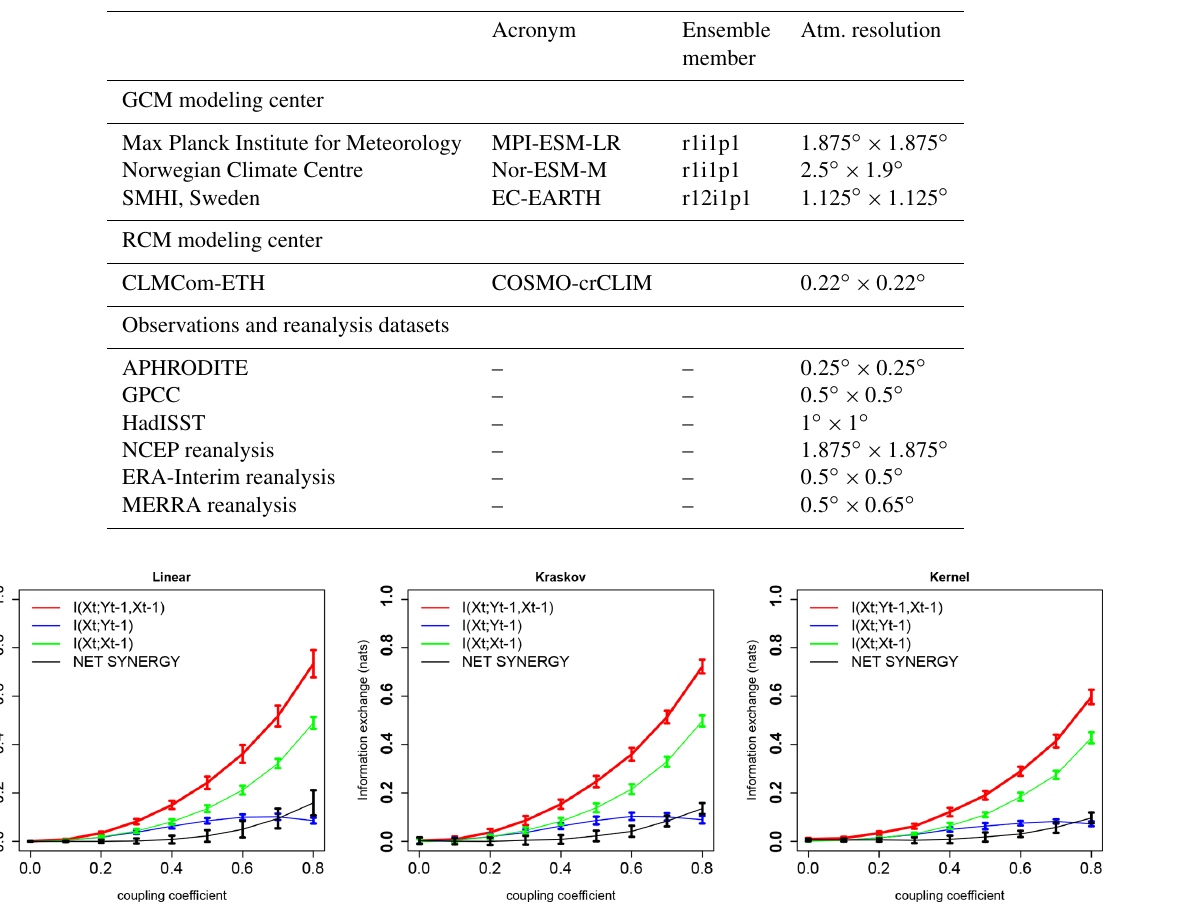
Table 1. CMIP5 GCMs, RCMs, and observation descriptions used in the current study.